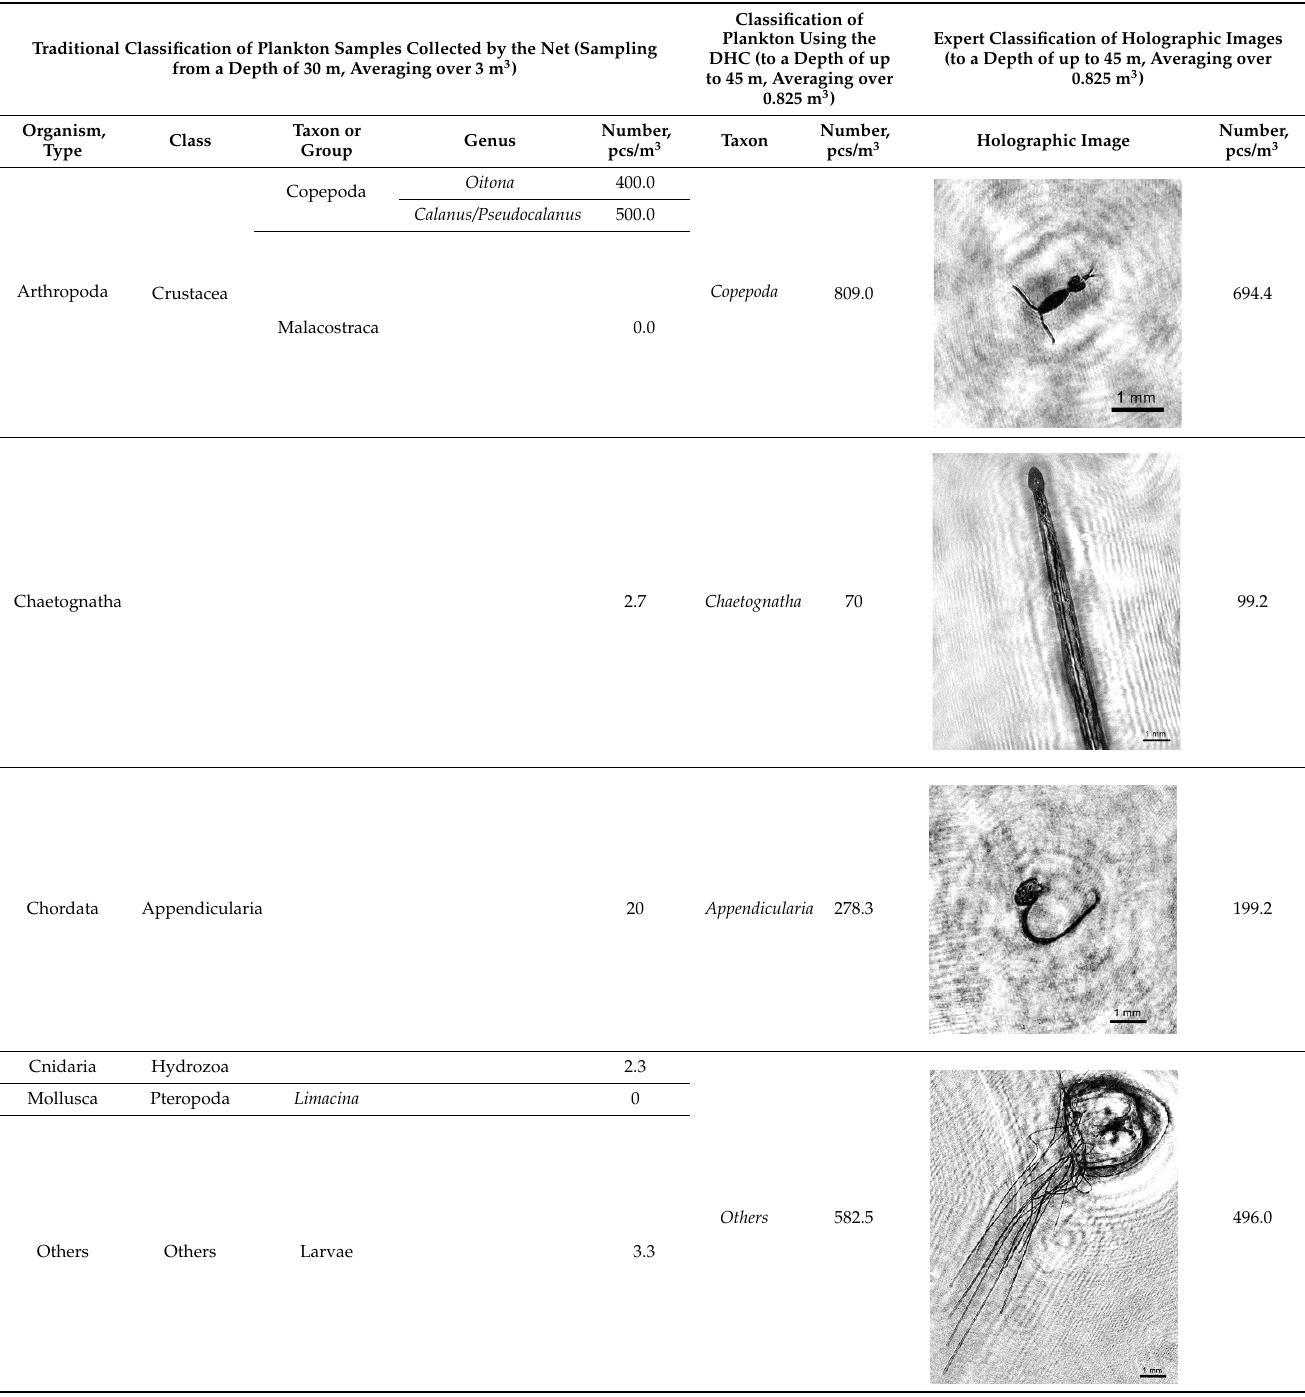
Table 6. Data for comparison of plankton measurements at station No. 6961.